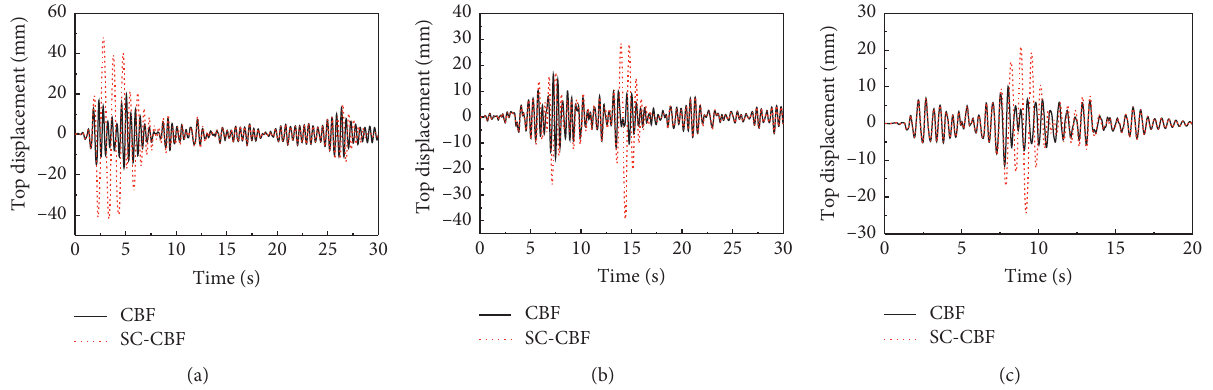
Figure 18: Top displacement versus time curves of the structure under rare earthquake: (a) El Centro wave; (b) Taft wave; (c) artificial wave.